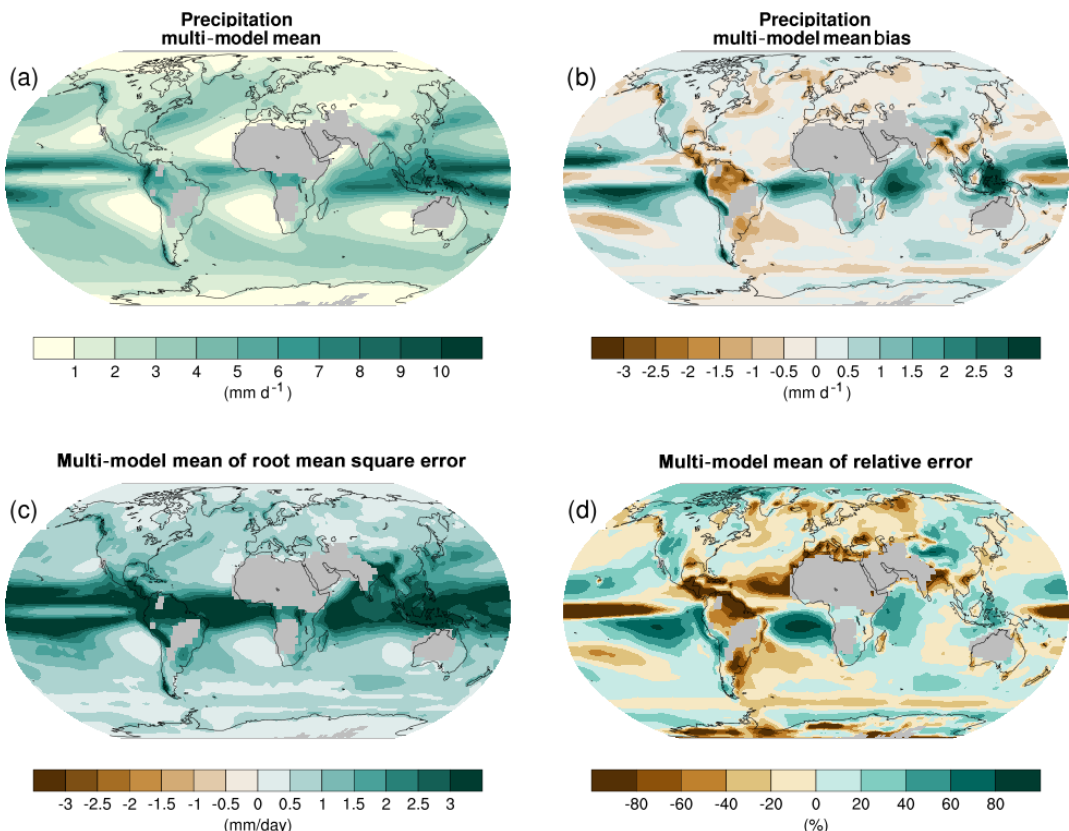
Figure 6. Annual-mean precipitation rate (mmd − 1 ) for the period 1980–2005. (a) Multi-model (ensemble) mean constructed with one realization of all available models used in the CMIP5 historical experiment. (b) Multi-model mean bias as the difference between the CMIP5 multi-model mean and the analyses from the Global Precipitation Climatology Project (Adler et al., 2003). (c) Mean root-mean-square error of the seasonal cycle with respect to observations. (d) Mean relative model error with respect to observations. Updated from Fig. 9.4 of IPCC WG I AR5 chap. 9 (Flato et al., 2013) and produced with recipe_flato13ipcc.yml ; see details in Sect.